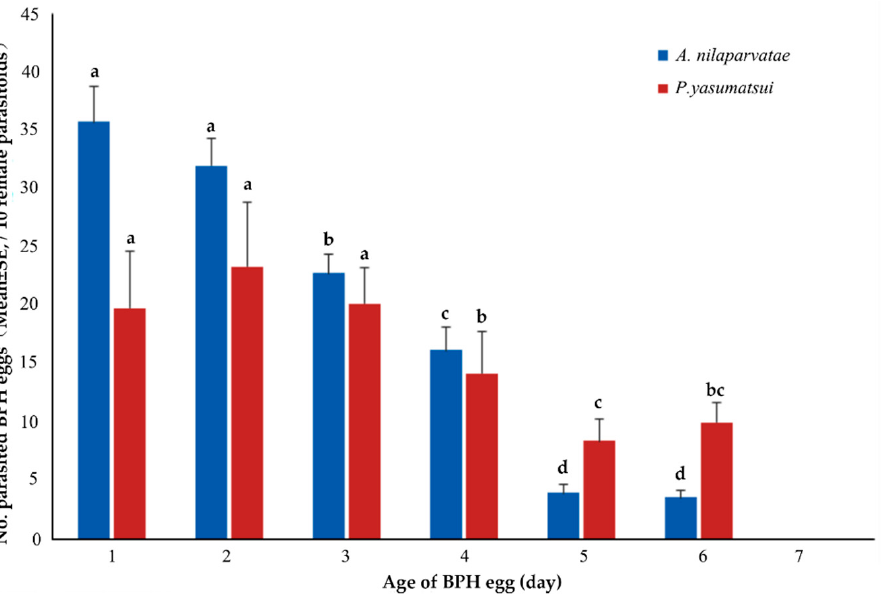
Figure 4. Parasitism preference of the two egg parasitoids among different ages of BPH eggs. Significant differences of the same egg parasitoid are marked with different letters (Tukey’ HSD, p < 0.05).